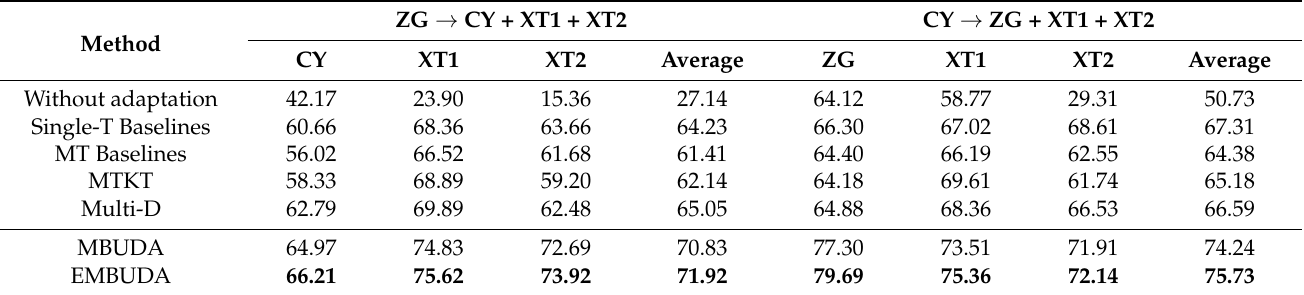
Table 5. The IoU of orchard area segmentation when the number of target domains is set to